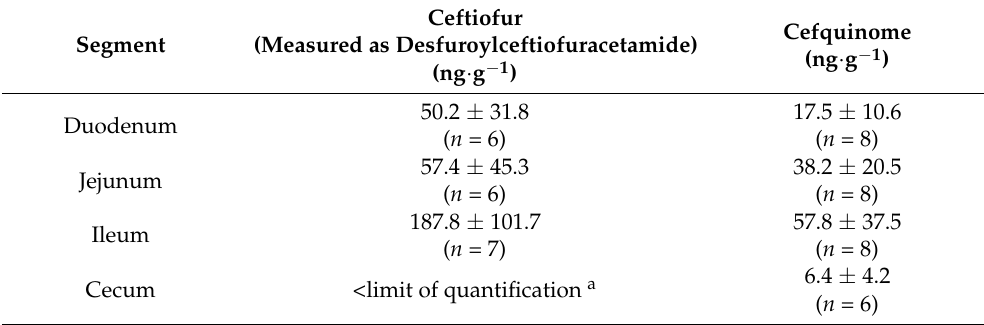
Table 2. Intestinal content concentrations (mean ± standard deviation) of ceftiofur-related residues (measured as desfuroylceftiofuracetamide) and cefquinome in the different gastro-intestinal segments at 11 h after last intramuscular administration of 3 mg · kg − 1 body weight ceftiofur or 2 mg · kg − 1 body weight